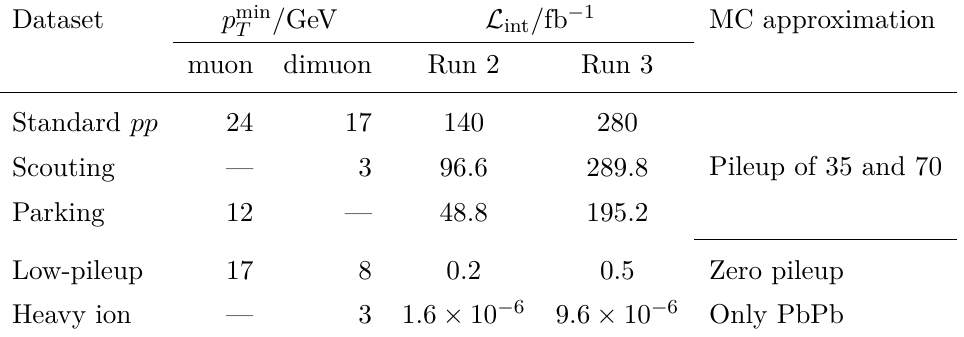
Table 1 : Comparison of the p thresholds of the single muon and dimuon triggers simulated in this T study, together with the integrated luminosities collected during the LHC Run 2 and the integrated luminosity expected after Run 3 for all datasets considered in this paper. Note that the integrated luminosity of the parking dataset is estimated from the number of events collected by CMS in Run 2 after the comparison with the b -quark cross section calculated using Pythia